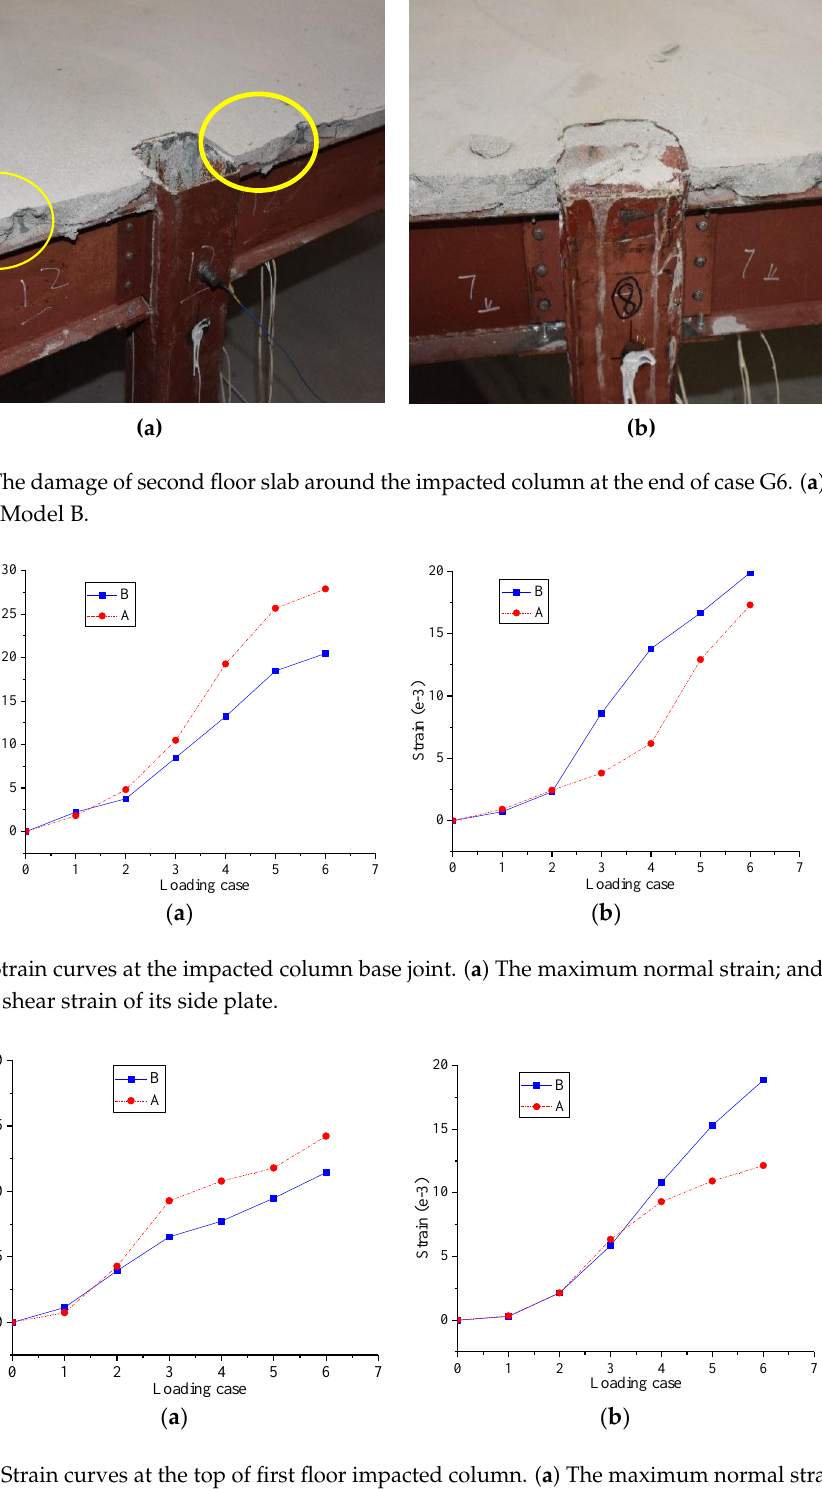
Figure 10. Strain curves at the top of first floor impacted column. ( a ) The maximum normal strain; and ( b ) the maximum shear strain of its side